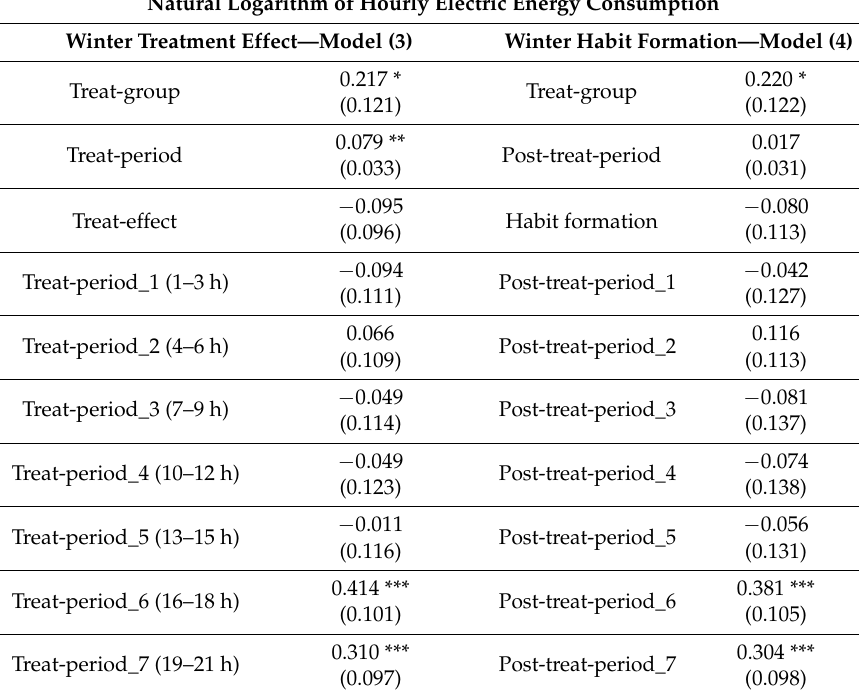
Table A2. Full regression results of the winter’s